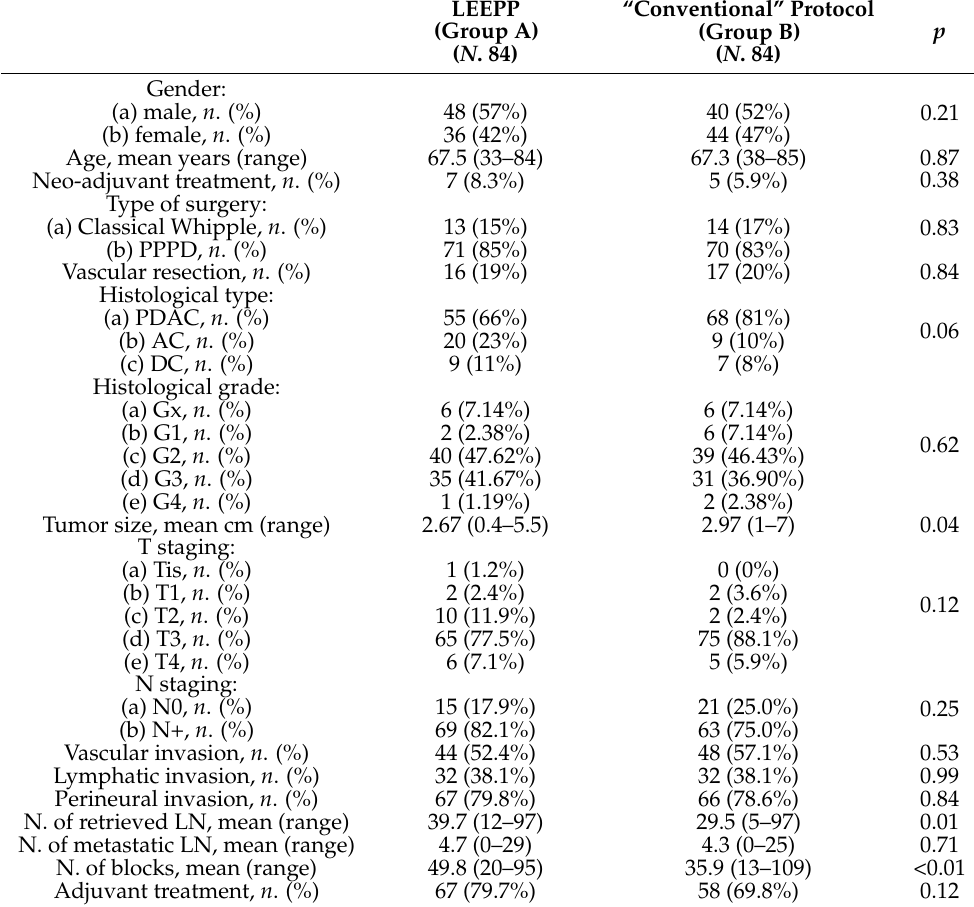
Table 1. Demographic, clinical, and histopathological